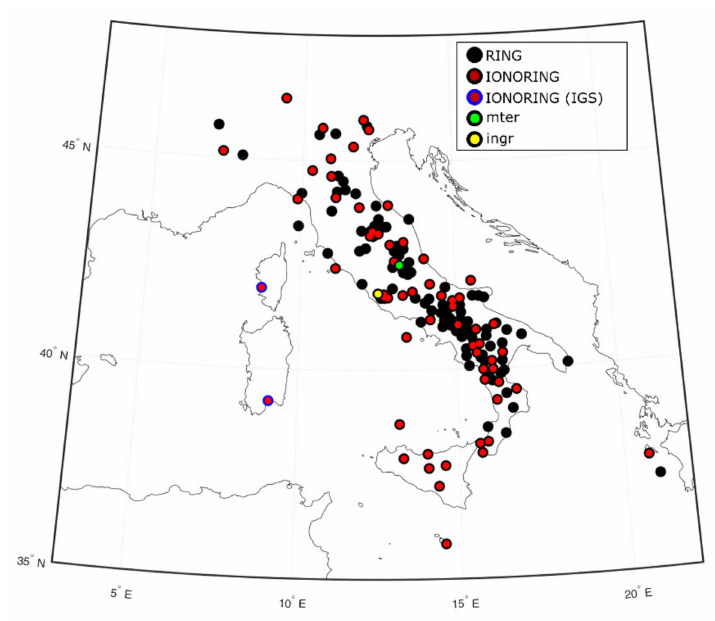
Figure 1. GPS receivers in RING (black circles) and in IGS (blue circles) networks; GPS receivers used for IONORING (red dotted); GPS receivers in Montereale (mter, 42.51 ◦ N 13.21 ◦ E, green dotted) and in INGV headquarter (ingr, 41.83 ◦ N 12.51 ◦ E), used for validation and positioning application purposes,